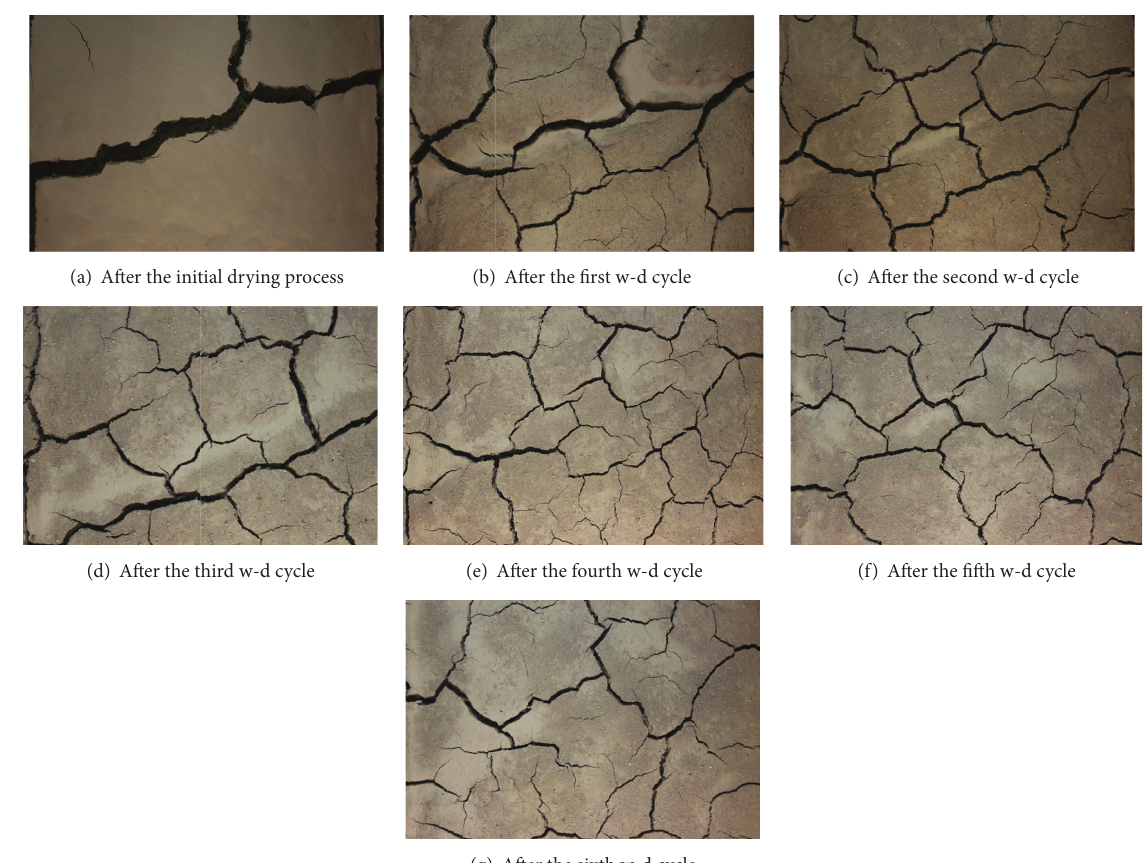
Figure 2: Cracks images at each end of drying